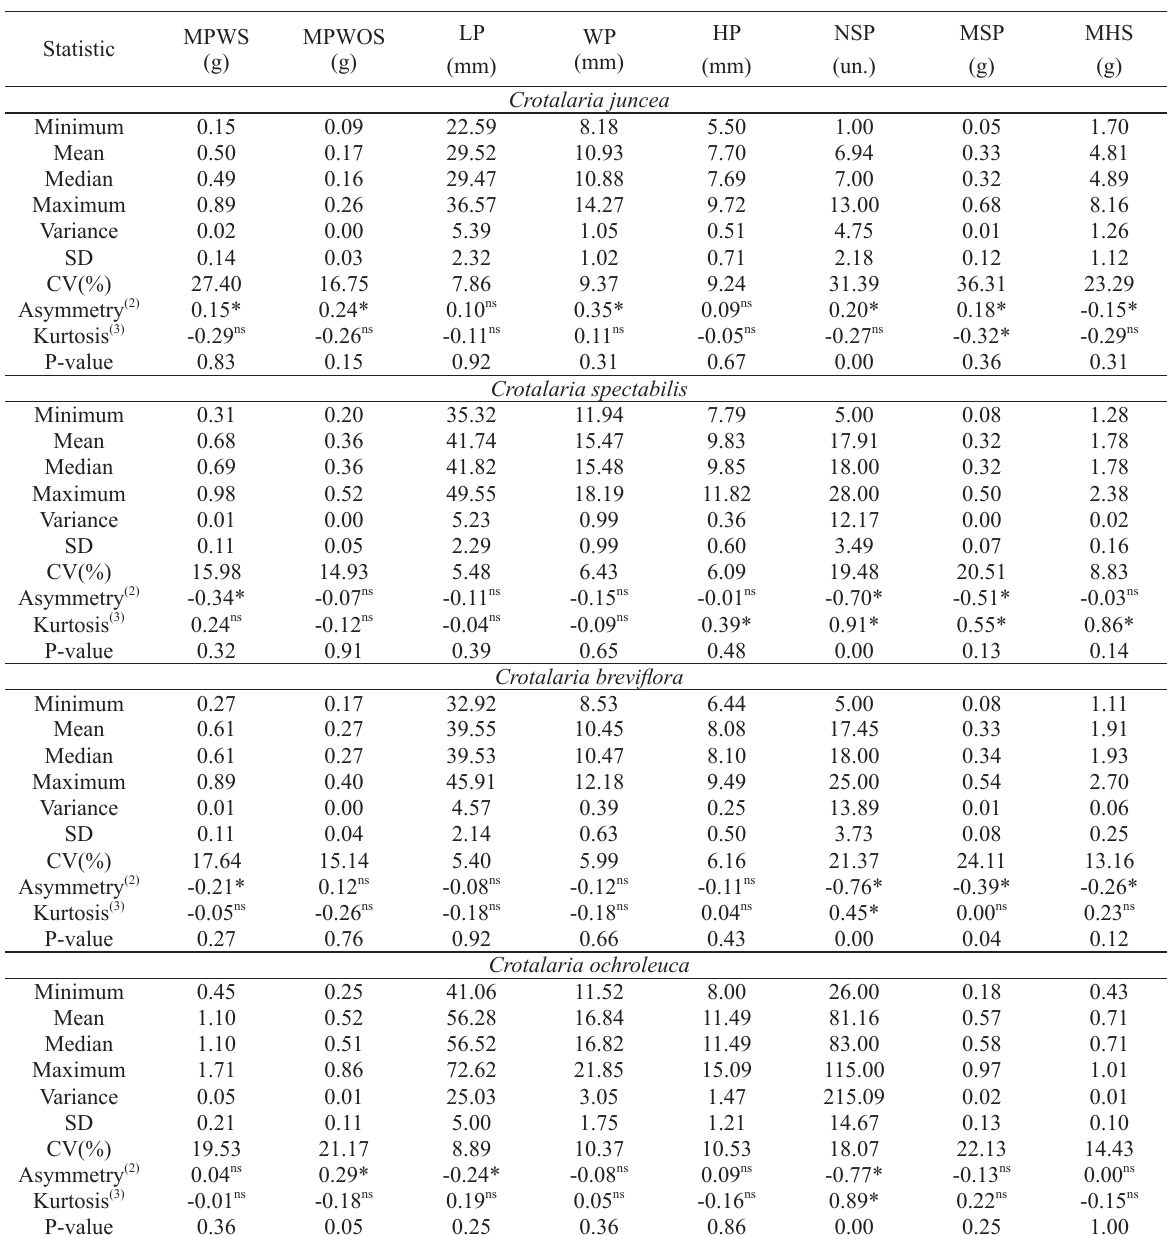
Minimum, mean, median, maximum, variance, standard deviation (SD), coefficient of variation (CV in %), asymmetry, kurtosis and p-value of the test of normality of Kolmogorov-Smirnov to eight characters measured in 1,000 pods of four species of crotalarias - C. juncea , C. spectabilis , C. breviflora and C. ochroleuca - in the season of 2014/15 in Itaqui - RS -